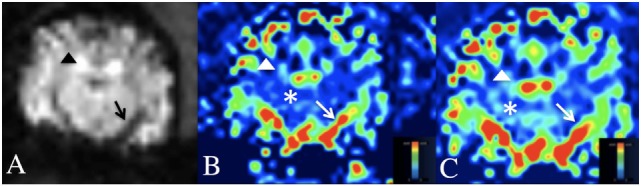
Dynamic susceptibility MRI (DSC-MRI) in the normal canine brain. (A) DSC-MRI T2*W image at the level of the middle cerebral artery. Note the hypointensity of the cortical arteries (black arrow head) and middle cerebral artery (black arrow) during the arterial first pass of the gadolinium contrast bolus. (B,C) Cerebral blood volume (B) and cerebral blood flow (C) maps at the level of the middle cerebral artery. A blue-red scale is used on these maps, where red is high perfusion and blue is low perfusion. Note the red middle cerebral arteries and red–green cortical arteries (white arrow and arrow head) and the blue–green cerebral parenchyma (white asterisks).